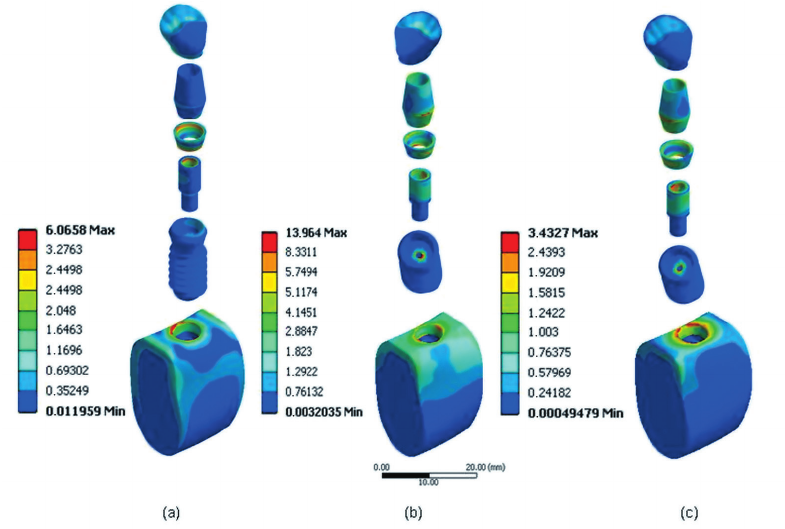
Figure 6- Von Mises stress levels in the elastomeric implant model components under different load cases. (a) Corono- apical load, (b) Linguo-buccal load, (c) Disto-mesial